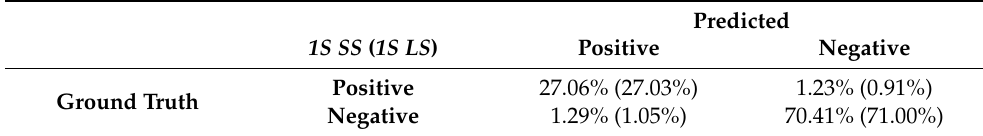
Table 2. Confusion matrix for 1S SS and 1S LS calculated over the single-image-patch predictions from the single-network application on the test datasets in 30 iterations.